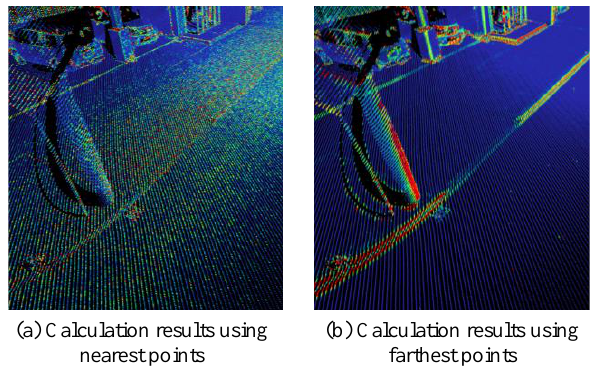
Figure 4. Influence of bend angle calculation using neighboring point selection method